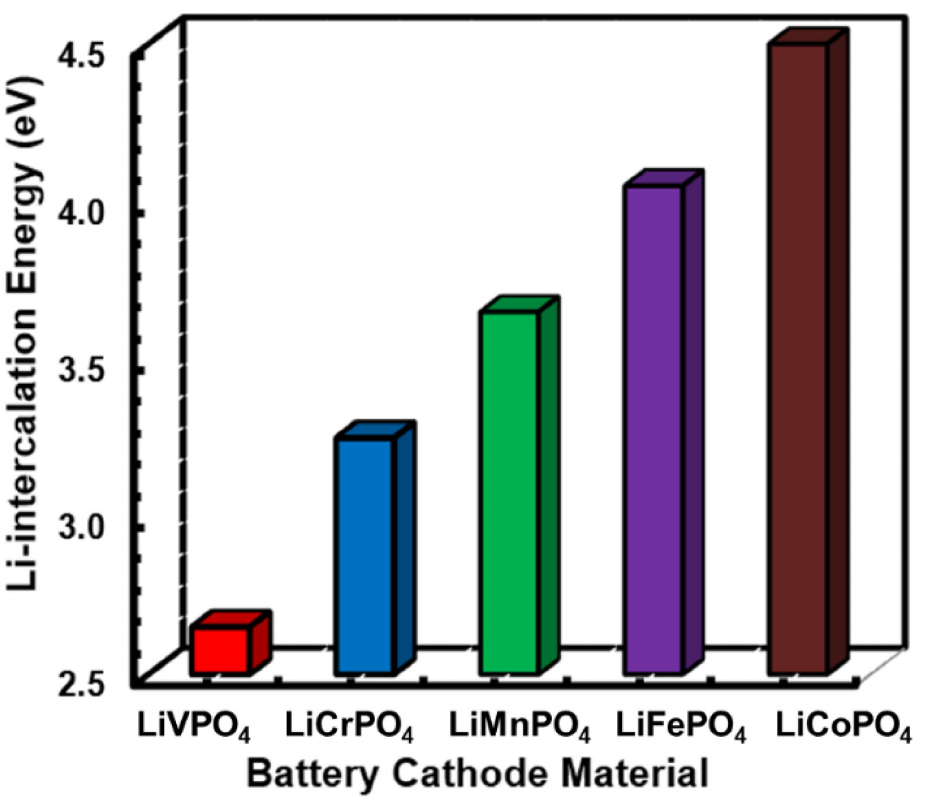
Figure 5. Comparative plots of lithium intercalation energies defined between completely lithiated and single Li-ion de-lithiated phases of the LiMPO 4